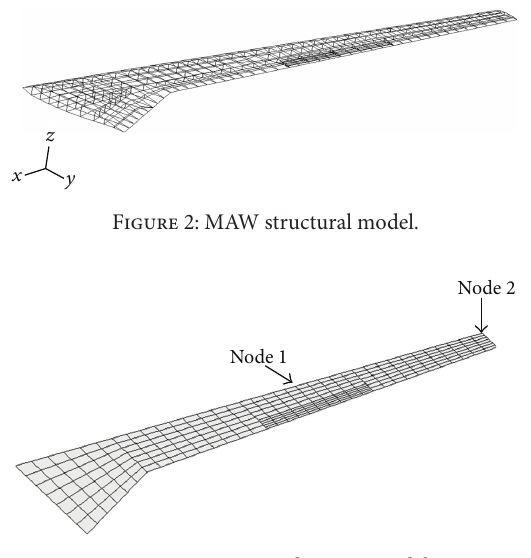
Figure 3: MAW aerodynamic